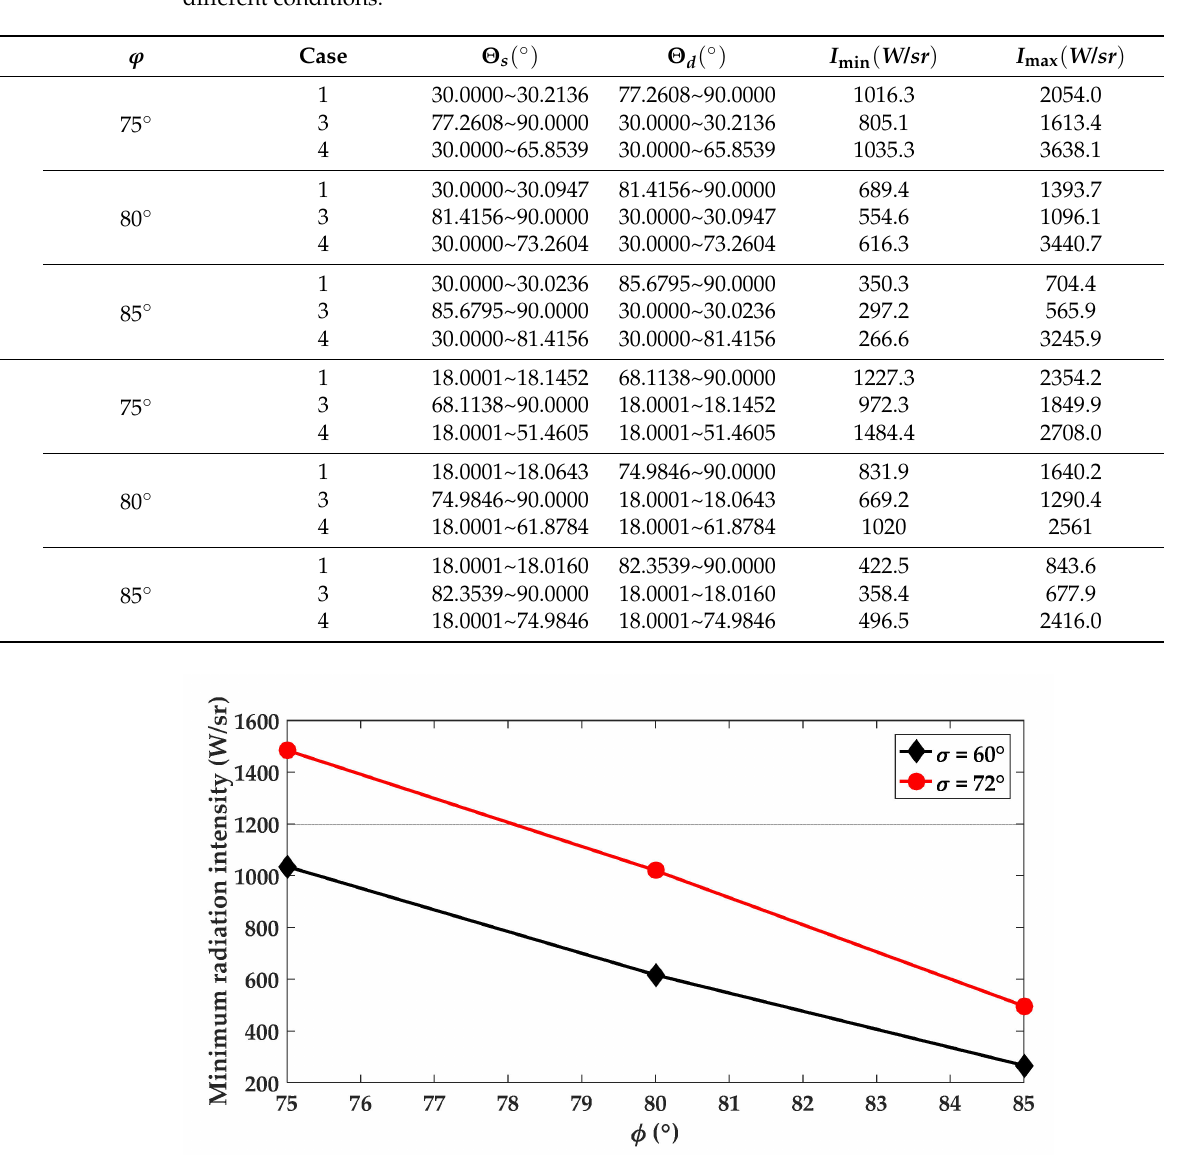
Figure 4. The minimum values of radiation intensity of space targets received by detectors under different